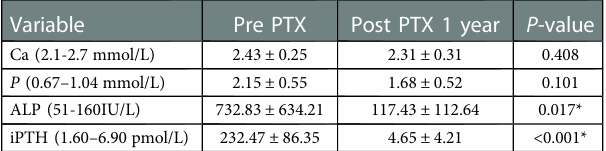
TABLE 3 Changes in the biochemical indices of patients before and one year after PTX.